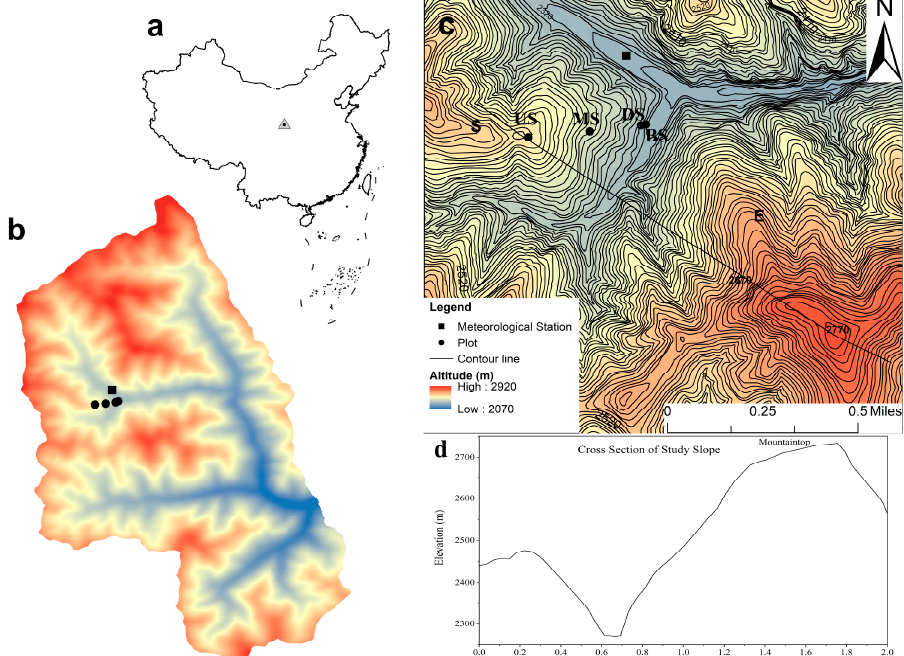
Figure 1. Information about the locations of the study sample plots and sample trees. ( a ) Location of the Xiangshuihe ( XSH ) study watershed in NW China. ( b ) The location of plots ( US , MS , DS and BS represent the upper, middle, down and bottom slope) along slope positions on the sample hillslope. ( c ) The detailed terrain of the study slope and opposite slope. ( d ) The valley cross-section.